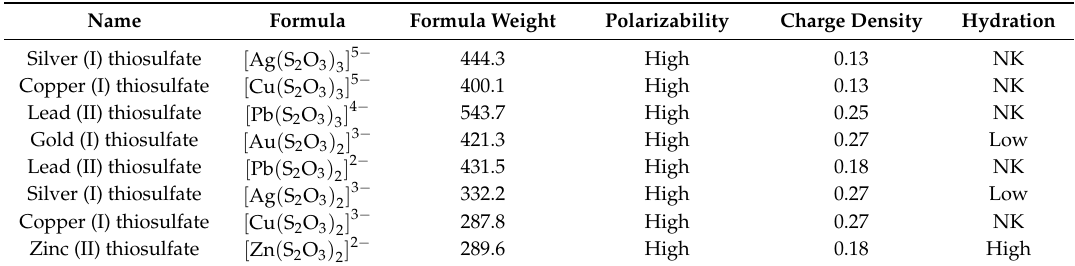
Table 5. Predicted selectivity of the resin for metal thiosulfate complexes presented in declining